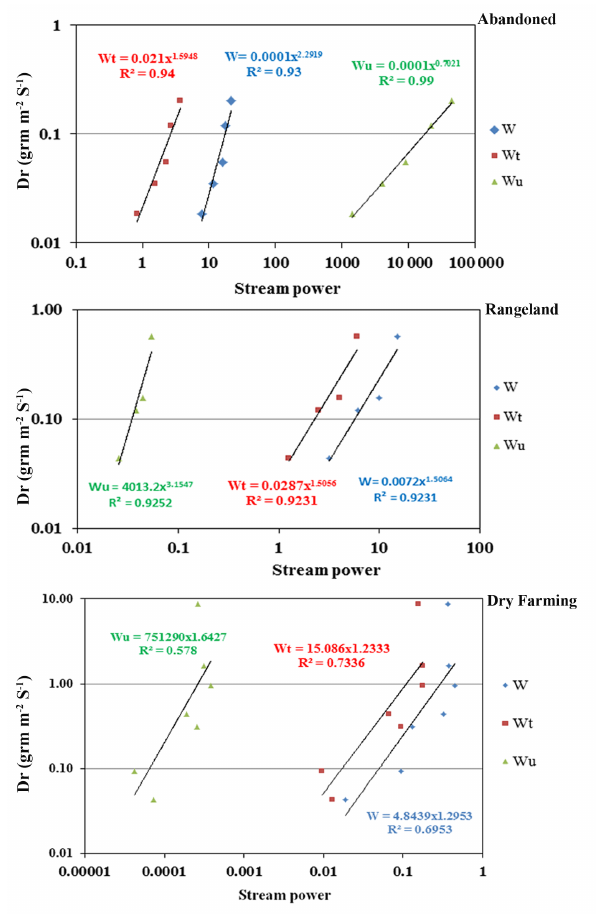
Figure 3. Relationship between stream power indices and detach- ment rate in different land uses ( P <